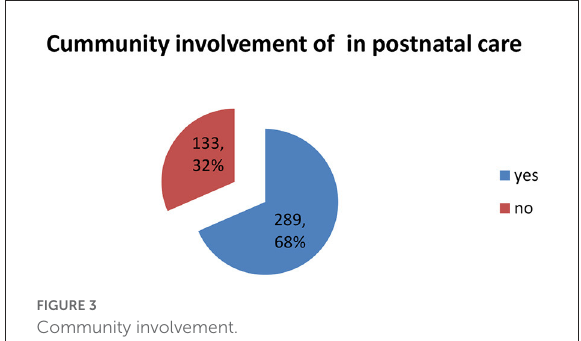
FIGURE3 Community